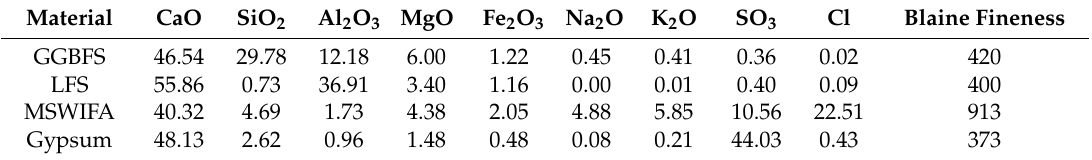
Table 1. Chemical composition (mass %) and Blaine fineness (m 2 /kg) of the raw materials. Material CaO